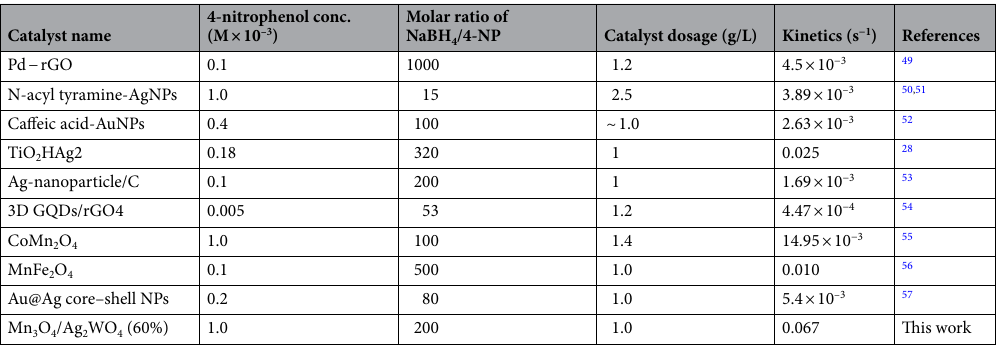
Table 2. Catalytic reaction rates summary of 4-NP on various reported catalysts under separate conditions at the room